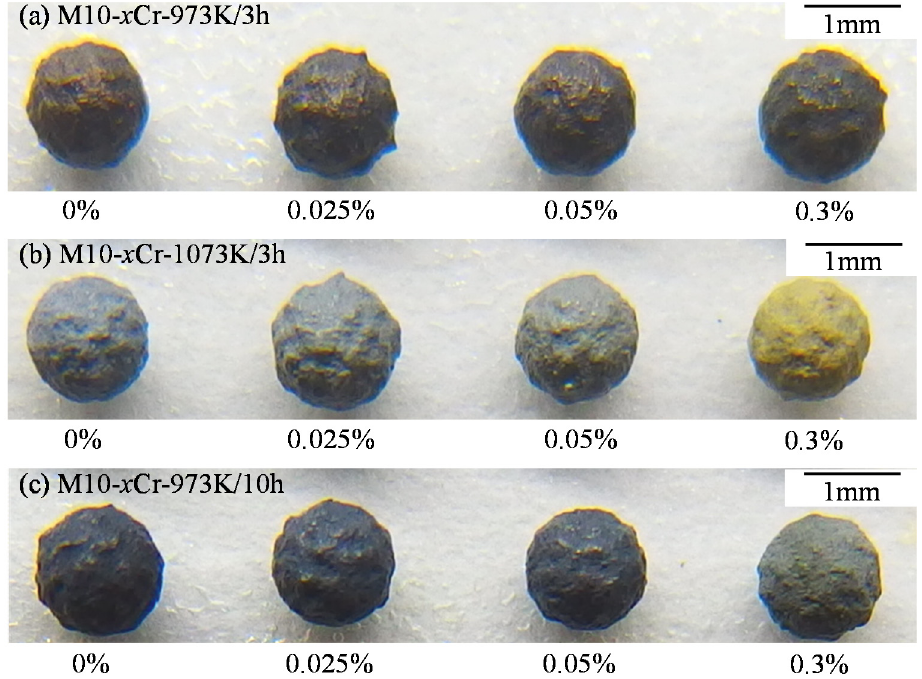
Figure 1. The appearance photograph of the samples. ( a ) M10- x Cr-973 K/3 h; ( b ) M10- x Cr- 1073 K/3 h; ( c ) M10- x Cr-973 K/10